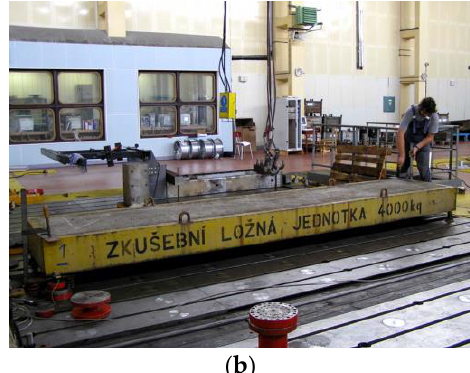
Figure 4. ( a ) Bogie fixed to the car platform; ( b ) loading unit.